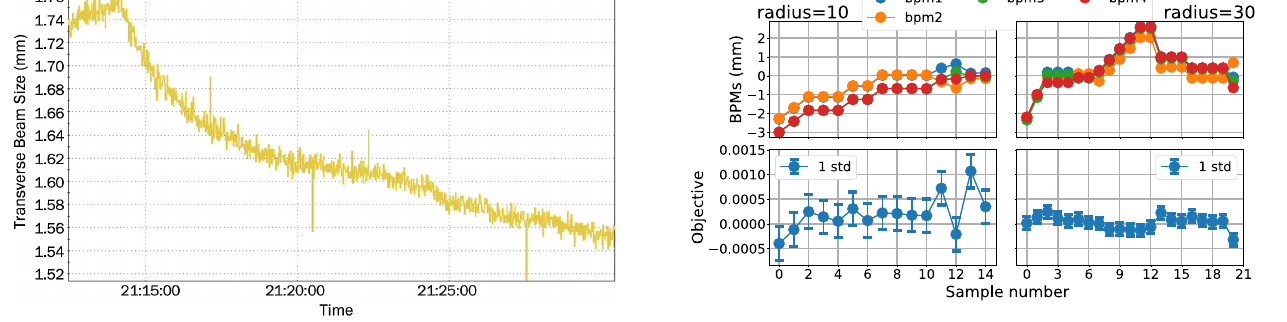
FIG. 7. An example period of transverse ion beam size data are fetched from the real system during the experiment. It shows the data are noisy.